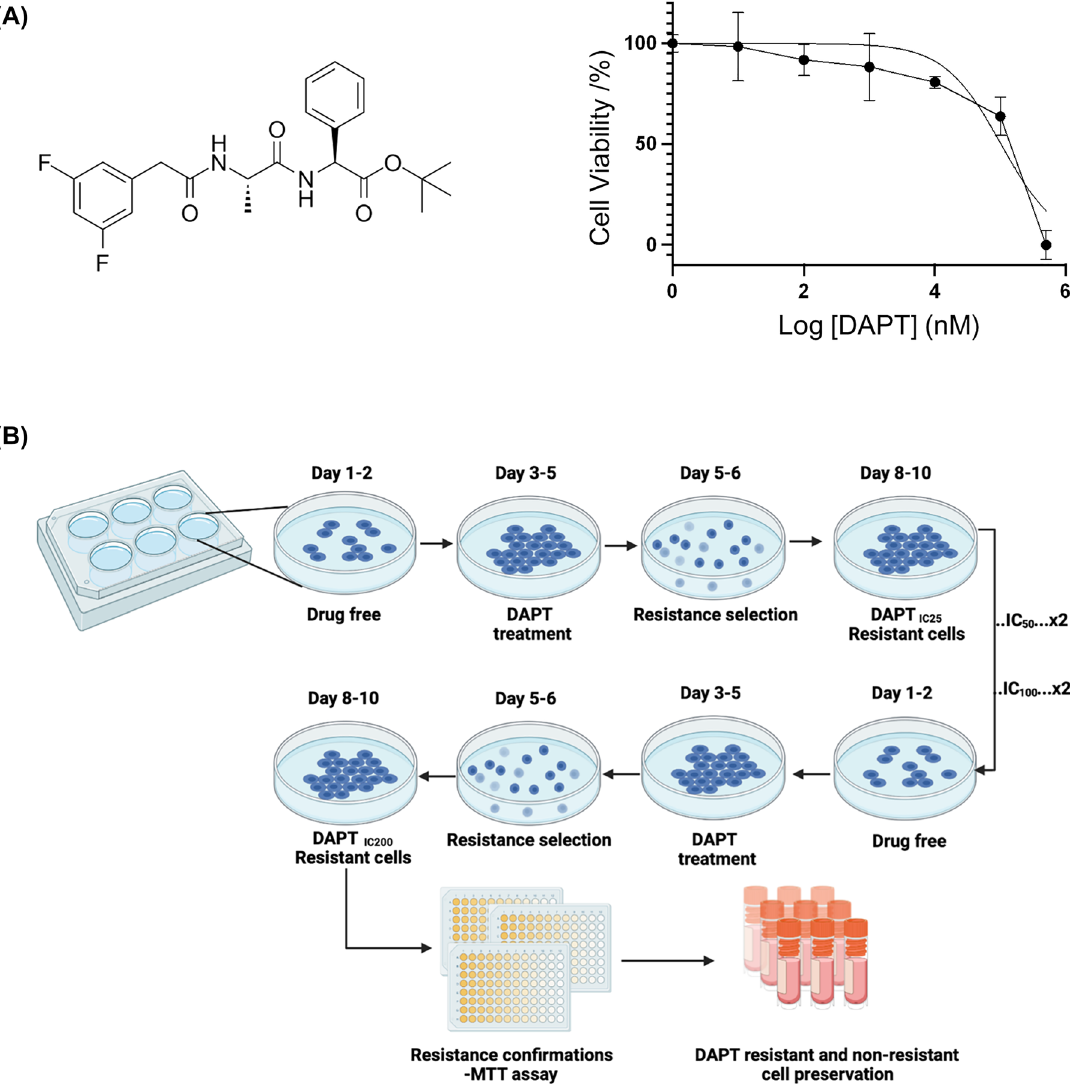
Figure 1: The experimental strategy to generate DAPT-resistant MCF-7 cells. (A) DAPT structure is shown on the left. IC 50 curve for MCF-7 cells treated withDAPTisontheright.CellviabilitypercentagewasplottedagainsttheDAPTconcentrationsonalogarithmicscale.Datarepresentthemeansand ± SD oftwoindependentexperimentsandthreemeasurements.(B)TheschematicexplanationoftheprotocolusedtogenerateDAPT-resistantcellsisshown. Each DAPT treatment was repeated a minimum of twice, along with DMSO controls. Cells were then preserved for further analysis. Viability changes of DAPT-resistant cells were con fi rmed with MTT